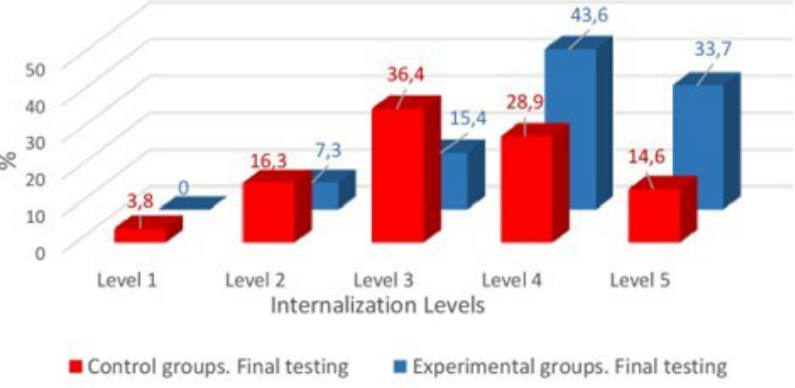
Figure 2 - Internalization growth from interpsychological to intrapsychological level of a foreign language mastering DOI: